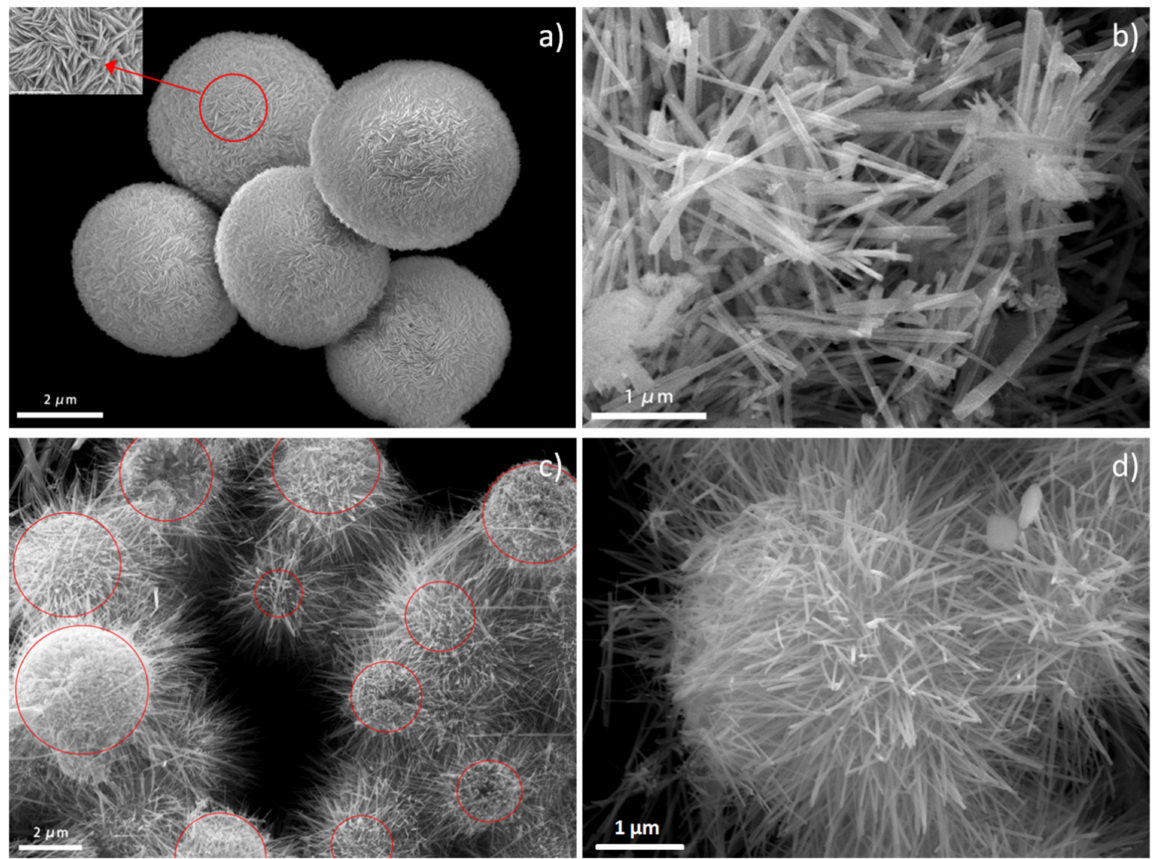
Figure 2. SEM images and partial enlarged images of ( a ) BiOBr, ( b ) Bi 2 S 3 and ( c , d ) BiOBr/Bi 2 S 3 /CdS composite.